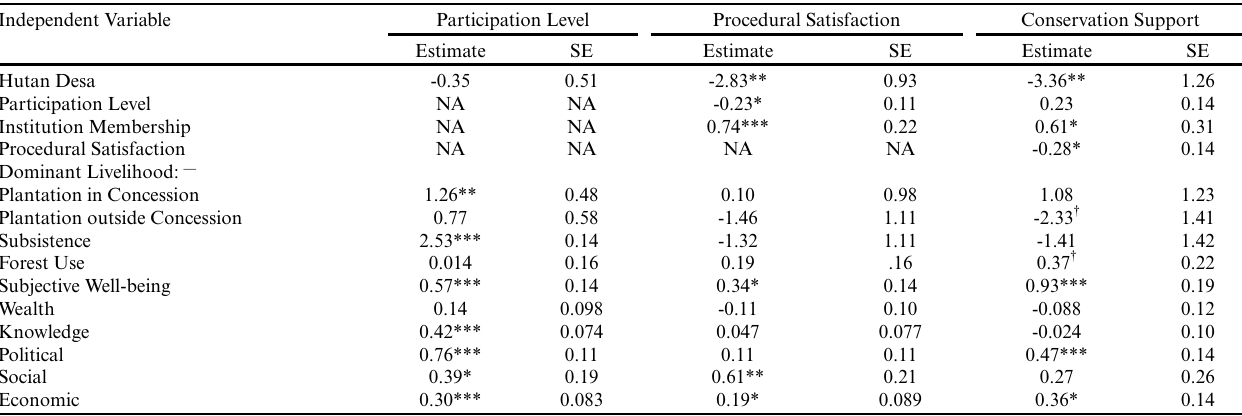
Table 3 . Empirical results from full cumulative link mixed models response variables (a) level of participation in village meetings, (b) procedural satisfaction, and (c) conservation support. Note that the reference level for dominant livelihood is other sectors. Independent Variable